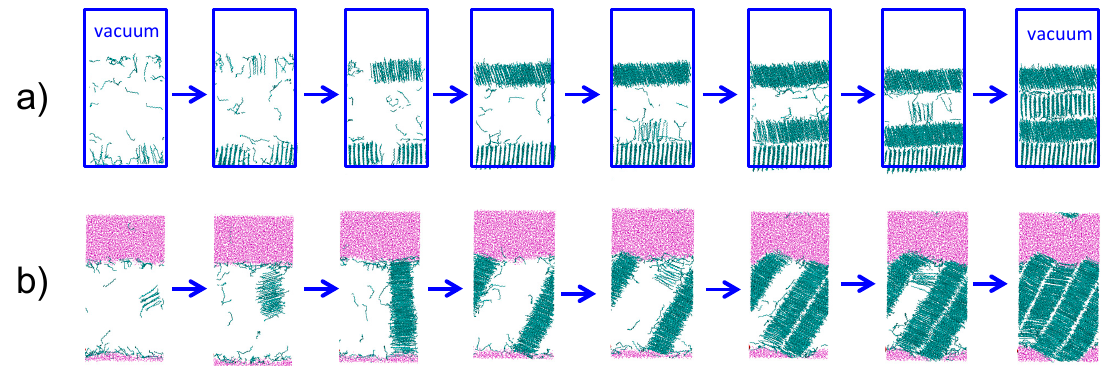
Figure 4. Snapshots of PYS hexadecane crystallizing ( a ) heterogeneously at the hexadecane–vacuum interface at 240 K and ( b ) homogeneously in the presence of water ( ε wc = 0.20 kcal·mol − 1 ) at 245 K. The induction time that precedes crystallization is not shown. Cyan lines indicate crystalline C16; the liquid alkane phase is hidden. Pink points represent water. Blue rectangles in ( a ) denote the boundaries of the periodic alkane/vacuum simulation box.